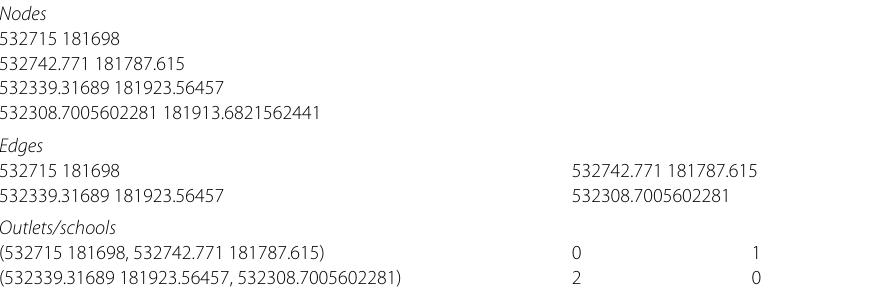
coordinates and edges count fast-food outlets as well as